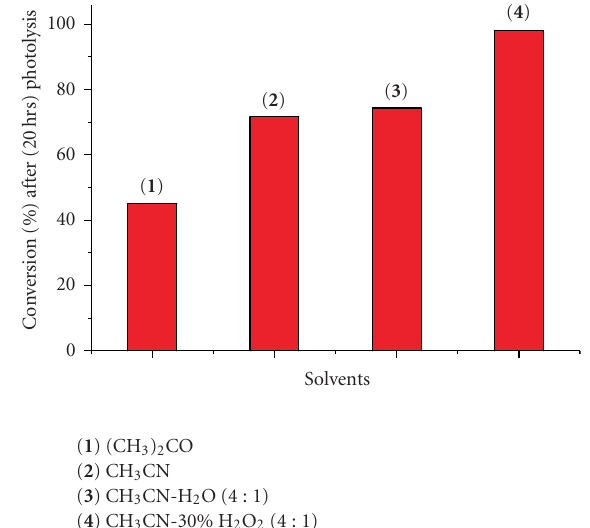
Figure 1: E ff ect of solvents on photocatalytic oxidation of cyclo- hexanol (1)